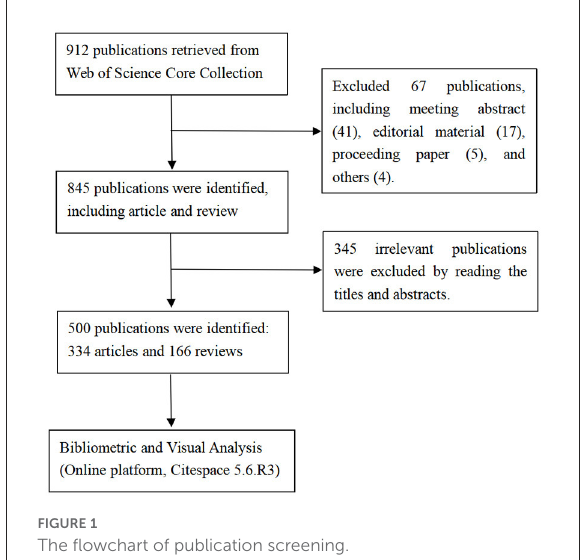
FIGURE1 The flowchart of publication screening.